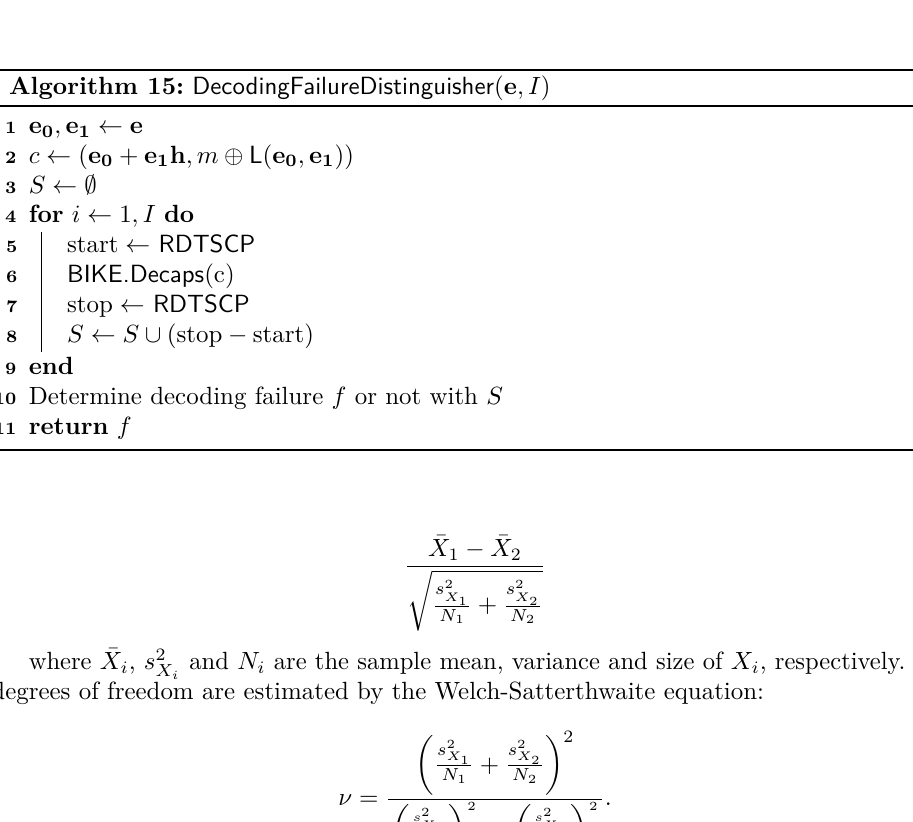
Key-Recovery Timing Attacks Due to Rejection-Sampling in HQC and BIKE